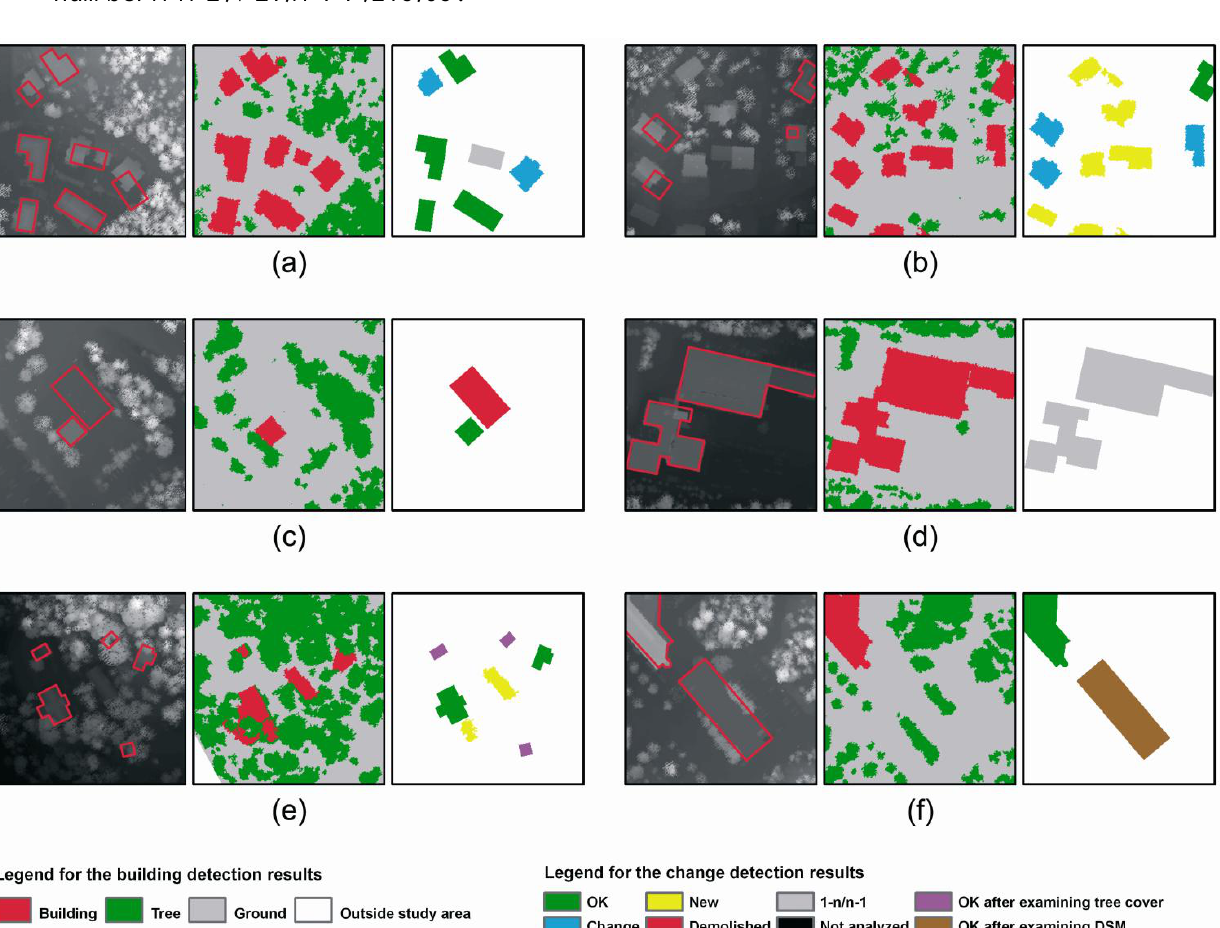
Figure 3. Examples of different change classes. The minimum DSM and old building map are presented on the left, the building detection result in the middle and the change detection result on the right (overlap approach used). (a) Unchanged buildings, changed buildings and a 1-n building. (b) New buildings, changed buildings and an unchanged building. (c) A demolished building and an unchanged building. (d) An n-1 building. (e) Buildings under trees (tree cover examined), unchanged buildings and new buildings. (f) A low car park (DSM examined) and an unchanged building. New and changed buildings for the change detection results were taken from building detection, others from the old map. Buildings of the old map  The National Land Survey of Finland 2001, permission number